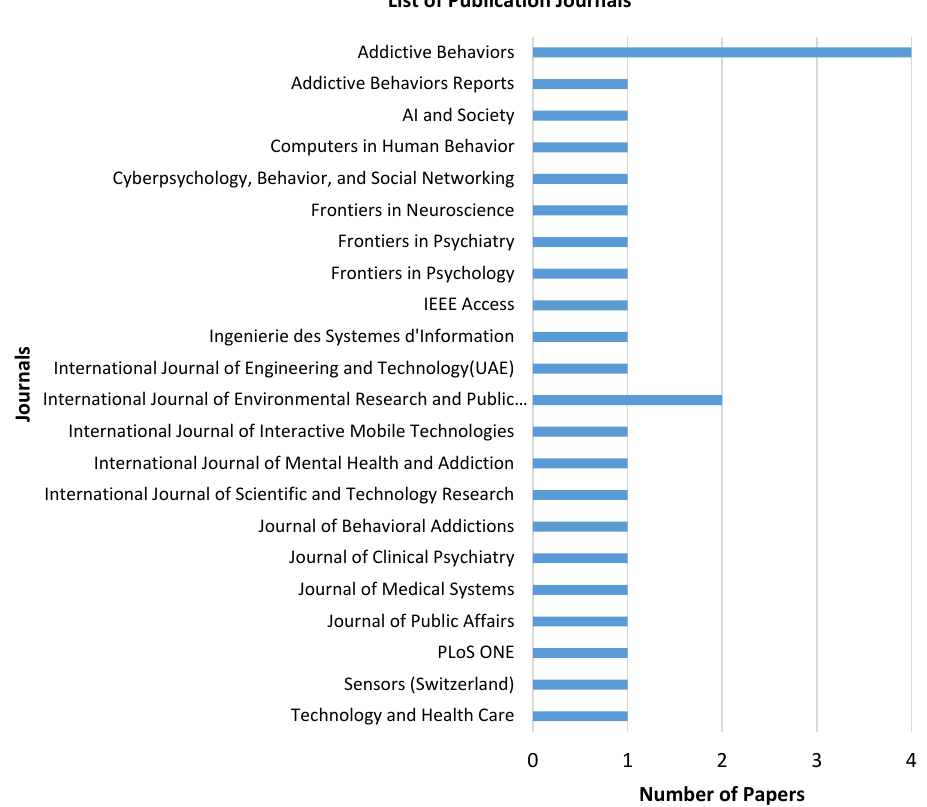
Figure 3. The number of papers published by year.